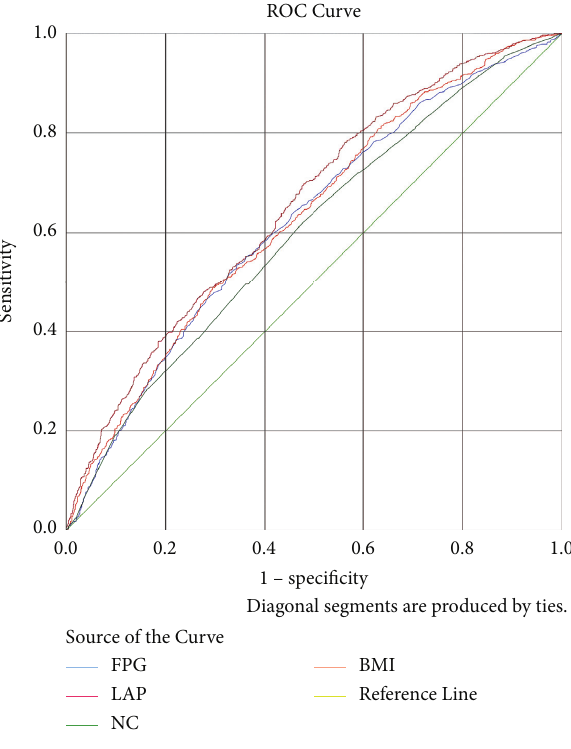
Figure 3: ROC curve of overall. Table 6: Predicting performance of factors in hypertension.